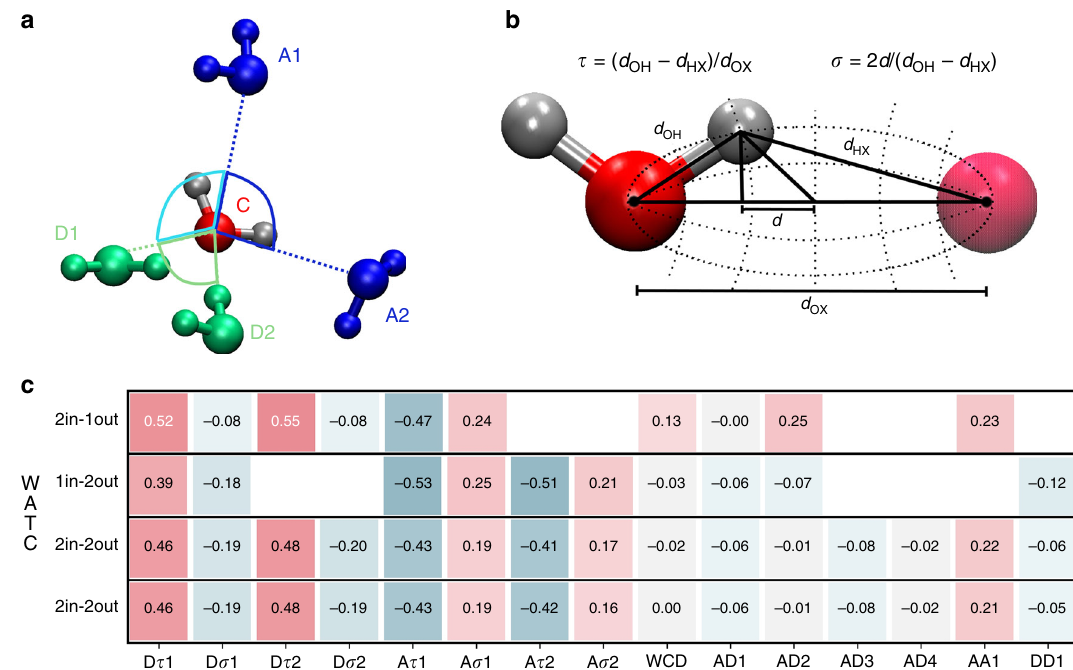
Fig. 9 Correlation between water charge and geometrical descriptors. a Angular coordinates for a tetrahedral coordinated water as reported in ref. 45 . The A tag is referred to the H 2 O molecules accepting a hydrogen bond from the central water. The D tag is referred to the H 2 O molecules donating an hydrogen bond to the central water. The subscript for each tag refers to the distance from the central water (i.e., A 1 is the nearest water to the central one accepting an OH bond from it). b Illustration of the proton transfer coordinates (PTC) in elliptical coordinates reproduced from ref. 77 . c Most relevant correlation coef fi cients (Pearson) calculated between the charge of the central water molecule (WATC) and the features shown in a and b . Only the results for the 2in-1out H 2 O in the 1st layer (1st row), 1in-2out in the 2nd layer (2nd row), 2in-2out in the 3rd and 4th layers (3rd and 4th row, respectively) are reported for brevity. The full correlation matrices for each species in every layer are reported in the Supplementary Information. The shorthanded labels for the PTC are: D τ x and D σ x that indicate the quantities shown in b for D1 and D2, respectively. The same notation is applied for A1 and A2 (i.e., A τ x, A σ x). WCD is the distance of the water molecule with respect to the Willard – Chandler interface. For the angular features, AA1 represents the d A 1 CA 2 angle, DD1 the d D 1 CD 2 angle, AD1 the d A 1 CD 1 angle, AD2 the d A 1 CD 2 angle, AD3 the d A 2 CD 1 angle, and AD4 is the d A 1 CD 1